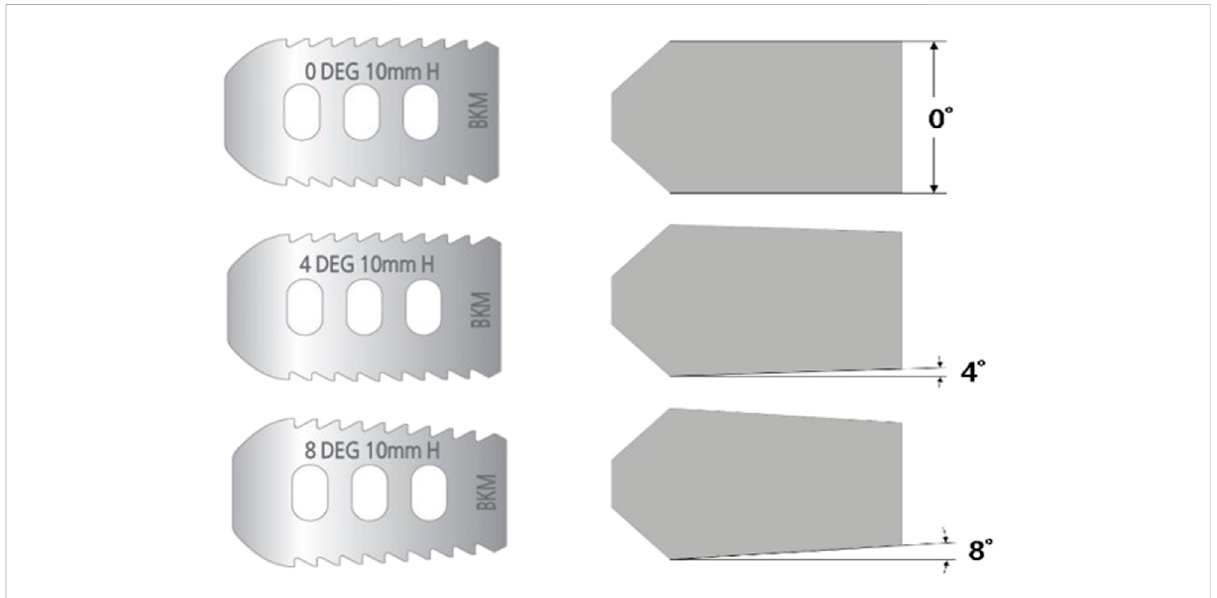
FIGURE 7 Simpli fi ed modeling of cage.